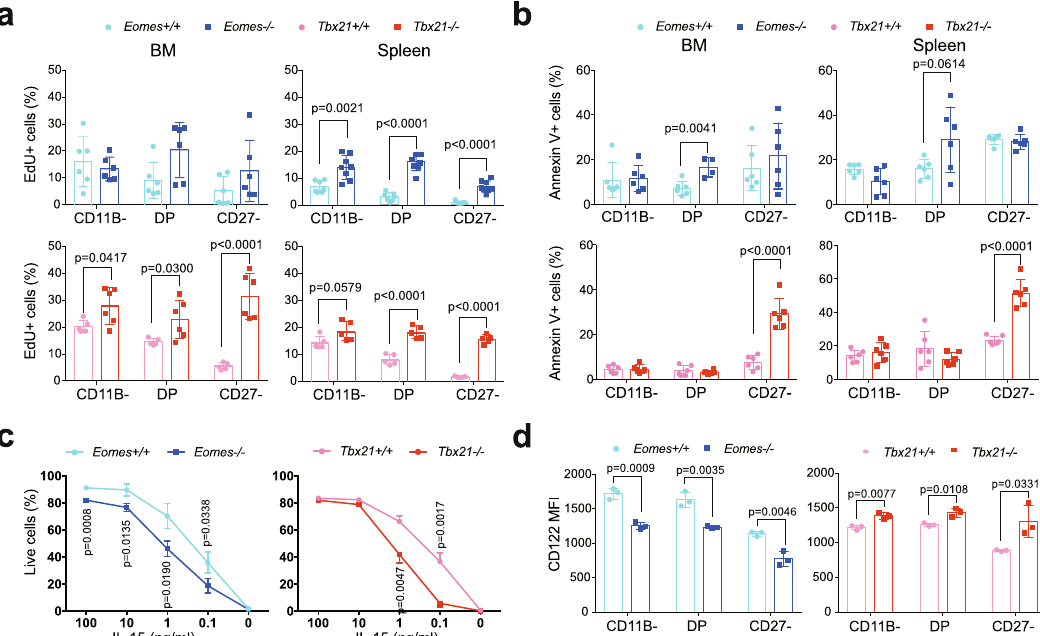
Fig. 3 EOMES and T-BET regulate NK cell proliferation and survival at different stages. a Mice were injected twice with EdU within a two-day-period, and EdU incorporation was measured in NK cells from the indicated organs by fl ow cytometry one day after the last injection. Each dot corresponds to a single mouse ( n = 6, pooled from 2 experiments), and graphs show the mean percentage± SD. b Ex vivo apoptosis of BM and spleen NK cell subsets as assessed by fl ow cytometry analysis of Annexin-V staining ( n = 5 – 6, pooled from 2 experiments). Bar graphs show the mean percentage ± SD of Annexin- V + cells within each subset, dots correspond to individual mice analyzed. c Total NK cell viability. Bar graphs show the mean percentage± SD of Annexin- V negative cells after culture of splenocytes with IL-15 for 48 h at the indicated concentrations. Data are from 3 mice representative of 2 independent experiments. d Flow cytometry measurement of CD122 expression in NK cells. Bar graphs show the MFI ± SD (one symbol per individual mouse analyzed). Paired t tests were used for statistical analysis of data presented in this fi gure. Data are from 3 mice representative of 2 independent experiments. Unpaired t tests (two-tailed) were used for statistical analysis of data presented in this fi